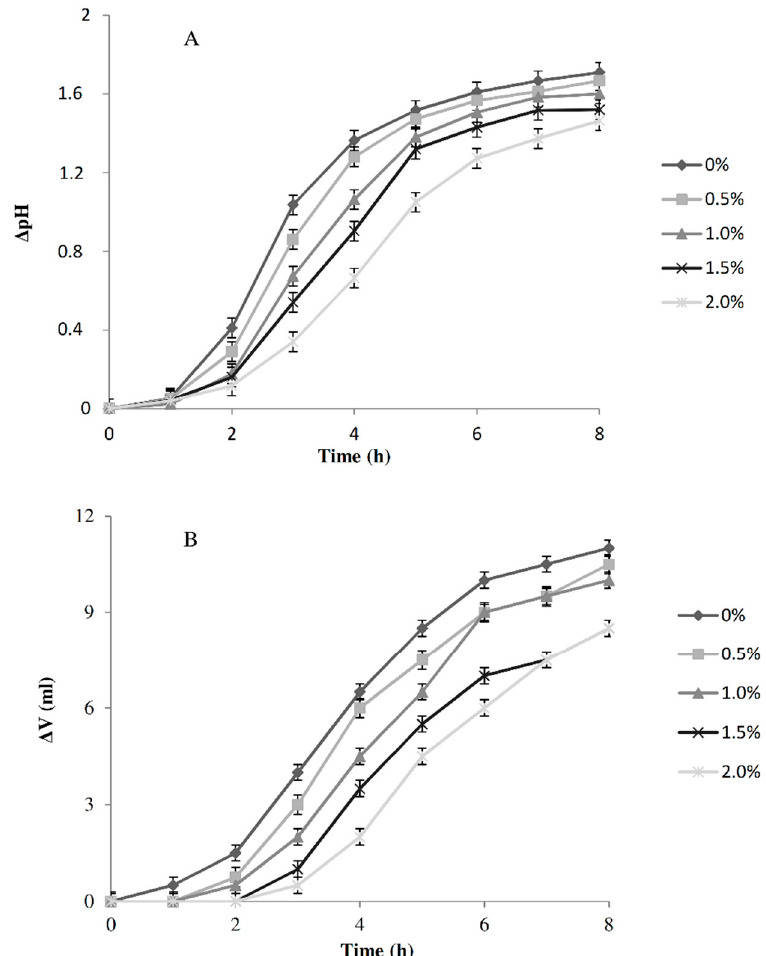
Figure 4. Variation of pH values ( ∆ pH, pH units) ( A ) and volume increase ( ∆ V, mL) ( B ) of doughs (DY 160) started with L. citreum C2.27 (initial cell number 7 log cfu/g), containing different percentages of salt: 0%, 0.5%, 1.0%, 1.5% and 2.0% (w/w). Fermentation was carried out at 30 °C for 8 h.